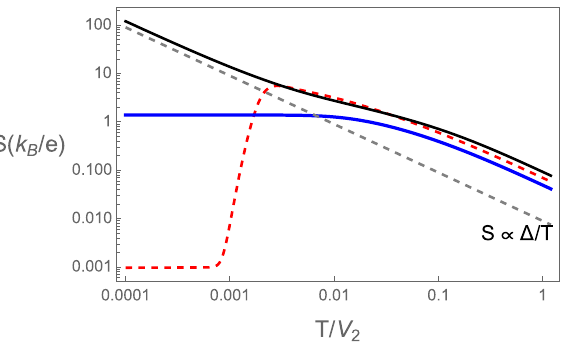
Figure 7. Thermopower of the device as a function of temperature in units of ( k B / e ) away and at the topological transition of the RM chains. Red dashed corresponds to ˜ V = 0.95 , such that the chains are in the topological phase. Black continuous shows the thermopower in the trivial phase, with ˜ V = 1.05 and blue at the topological transition. The gray dashed line shows the classical result for a semiconductor with activation energy (cid:31)